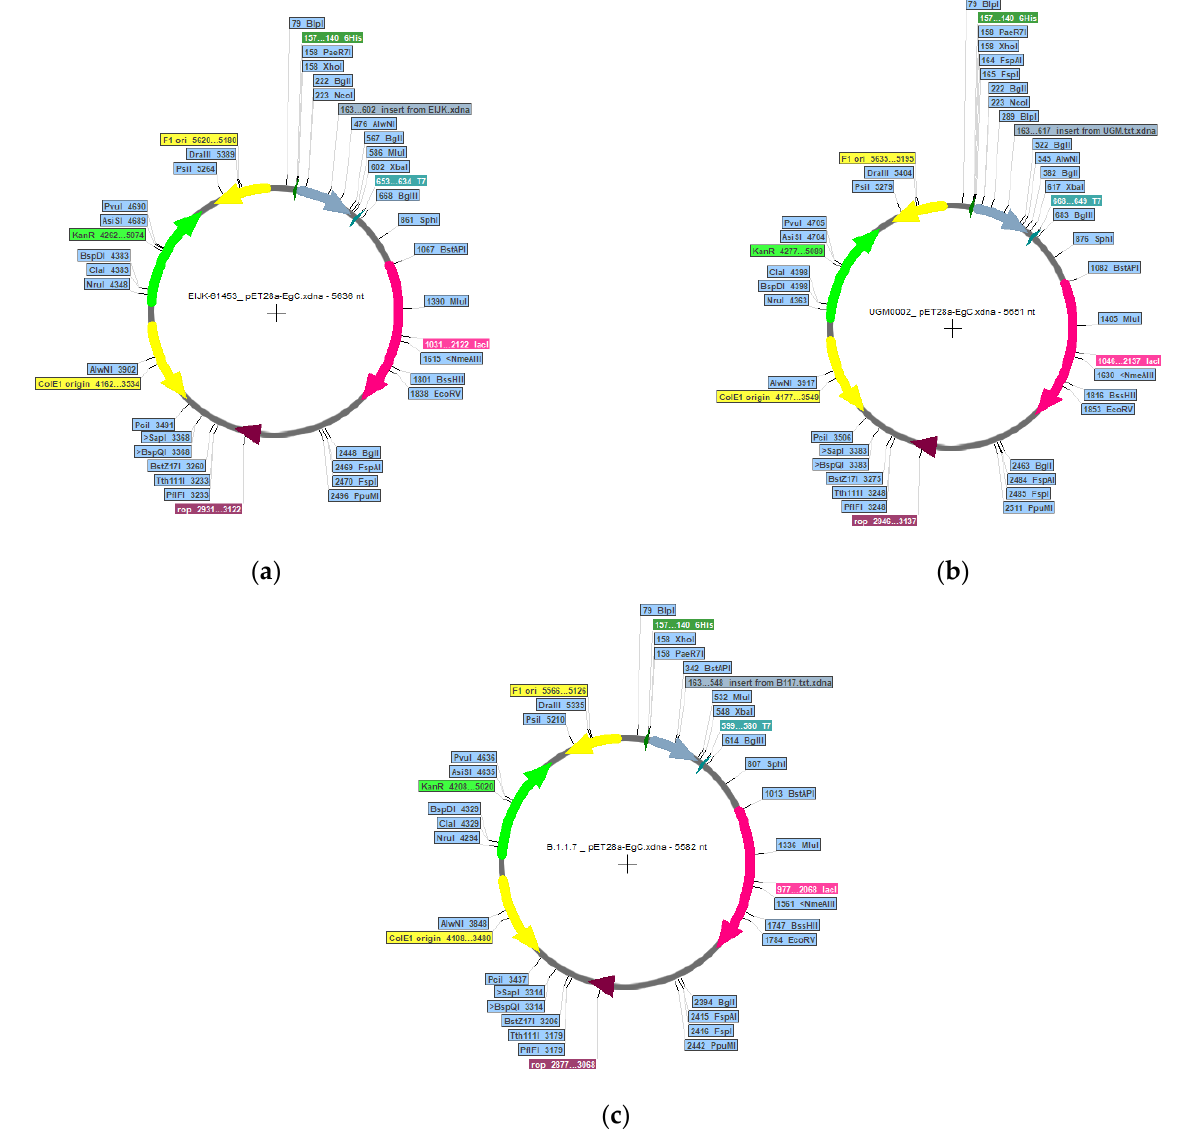
Figure 11. In silico cloning design of EIJK-61453 ( a ), UGM0002 ( b ), and B.1.1.7 ( c ) vaccine to pET28a- EgC vector. The vaccine sequence is shown by the blue-grey color arrow.